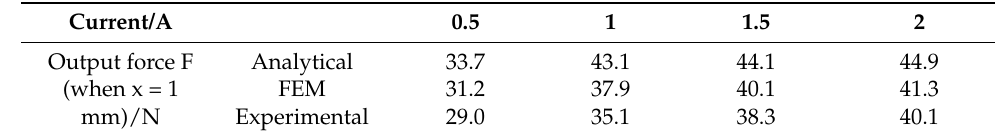
Figure 17. Force-displacement characteristic curve. ( a ) 0.5 A. ( b ) 1 A. ( c ) 1.5 A. ( d ) 2 A. Table 8. Summary of the magnetic flux density of 𝛿 1 and 𝛿 3 (x = 0.8 mm).